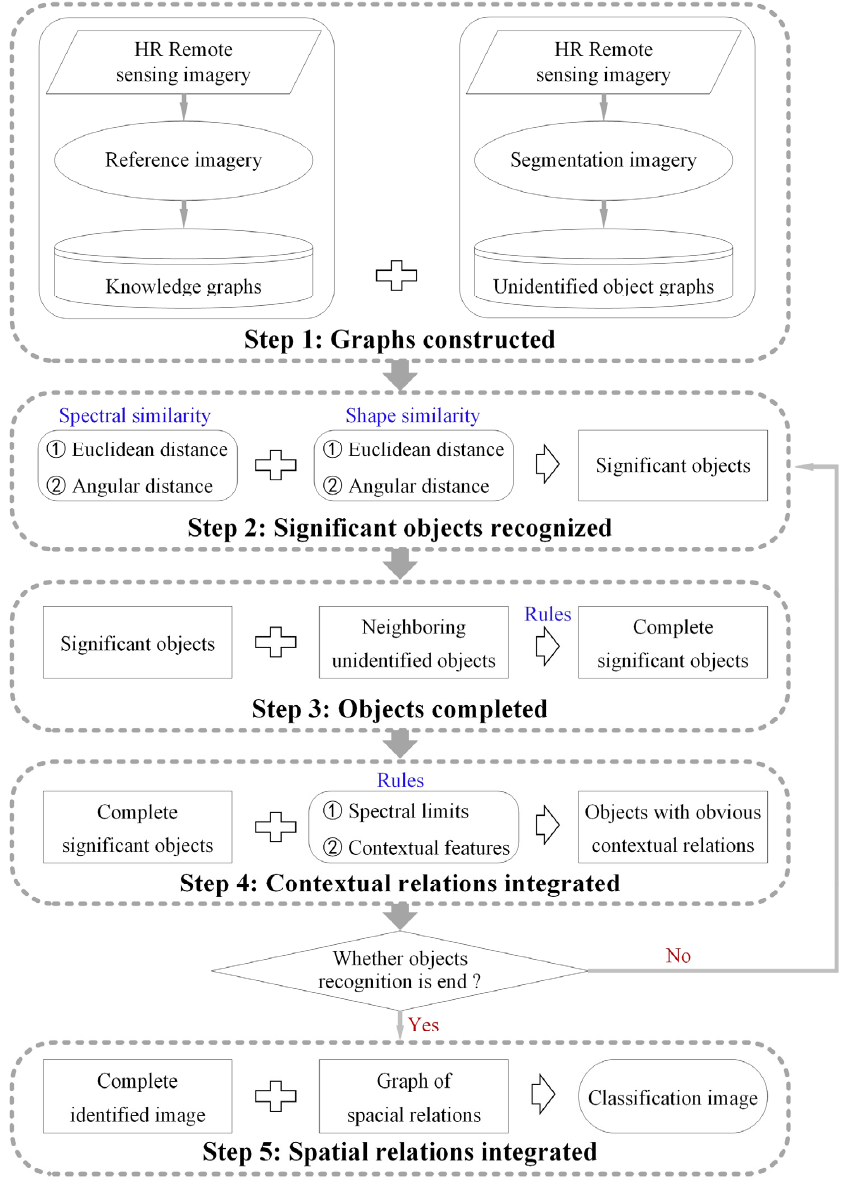
Figure 2. Flowchart of the proposed classification method.